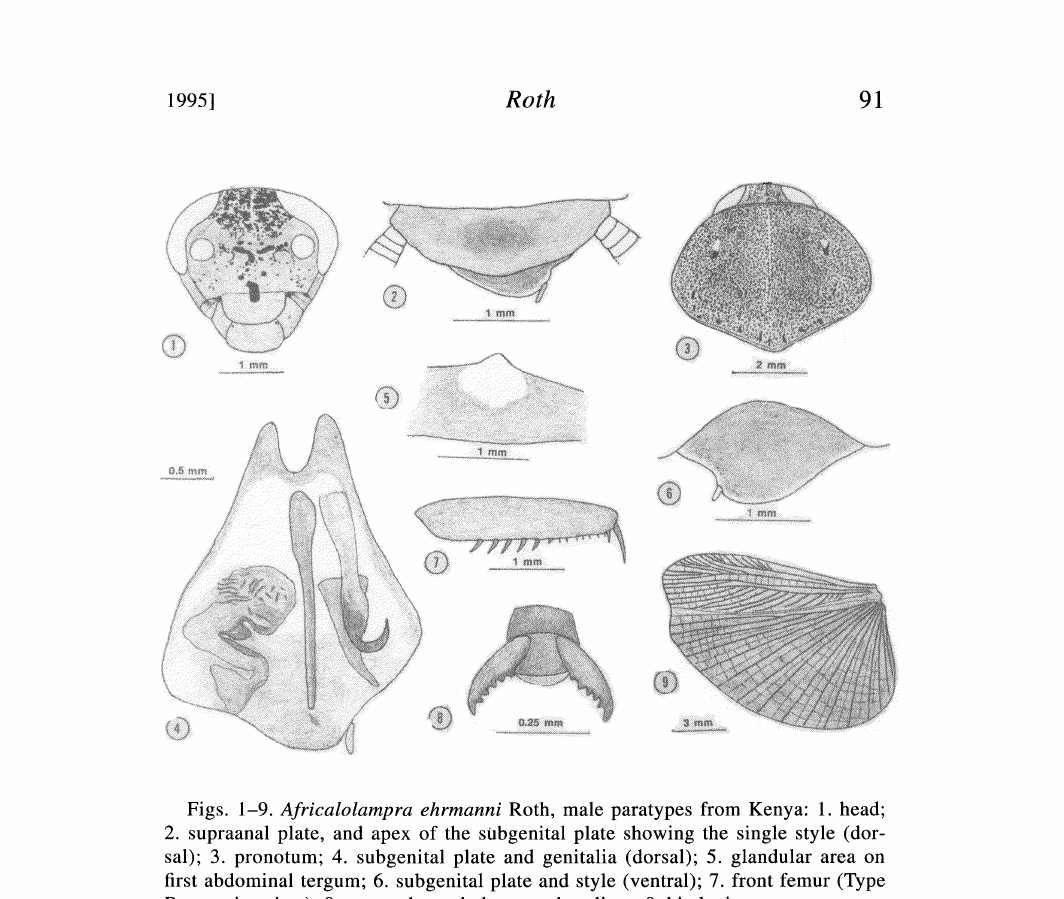
Paratypes: MCZ: same data as holotype, 4or (2 with terminalia slides 294 & 297),